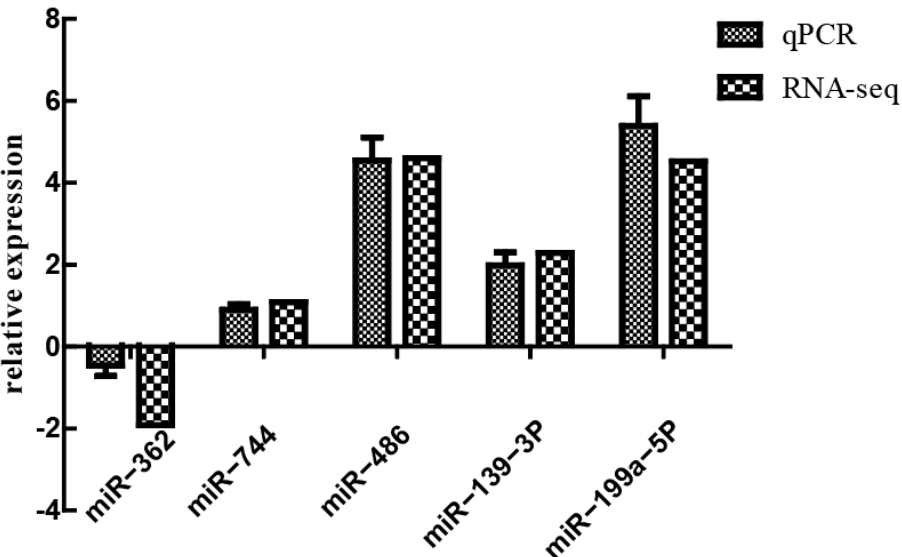
Figure 9. Relative expression of selected miRNA genes determined via qPCR.